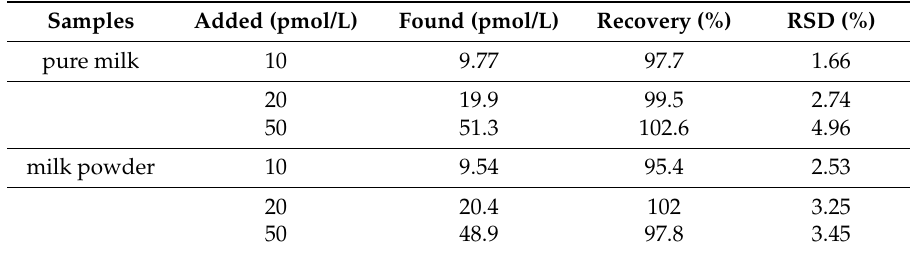
Table 3. Detection of Clostridium perfringens in dairy products by CeO 2 /CHIT nanocomposite-based DNA